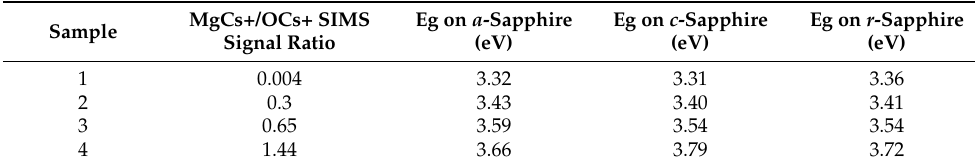
Table 2. Energy gaps (Eg) obtained at